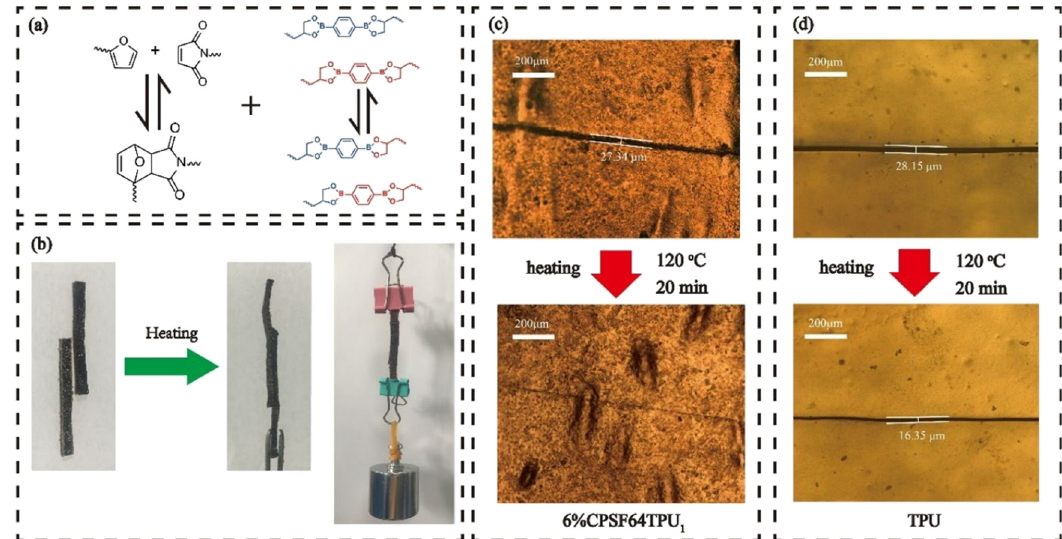
Figure 6: ( a ) Schematic representation of the DA reaction ( right ) and the transesteri fi cation reaction of boronic ester linkages ( right ) ; ( b ) optical images of welding behaviors of 6% CPSFTPU 1 sample, optical microscopy images of the 6% CPSFTPU 1 and TPU fracture surface before and after self - healing: ( c ) for 6% CPSFTPU 1 and ( d ) for TPU. Copyright 2021, Molecular Diversity Preservation International ( 90 )